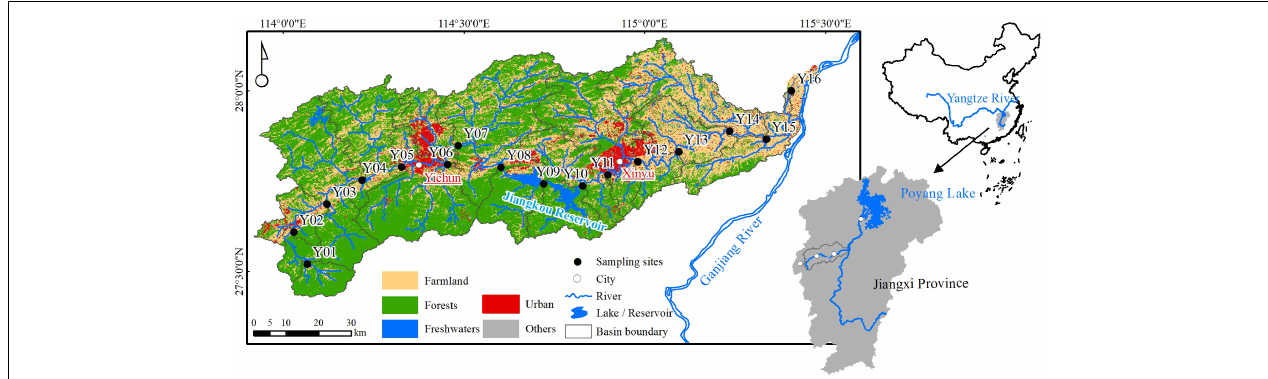
FIGURE 1 | Map of the Yuan River and sampling sites. The cities of Pingxiang, Yichun, and Xinyu are located upstream and downstream in the Yuan River